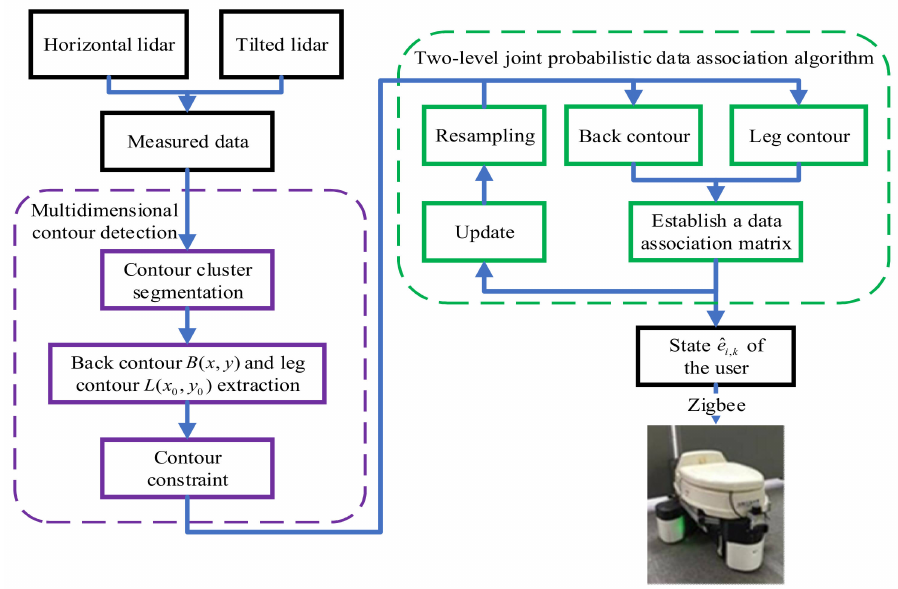
Figure 4. The diagram for the two-level JPDA based on the multi-constraint